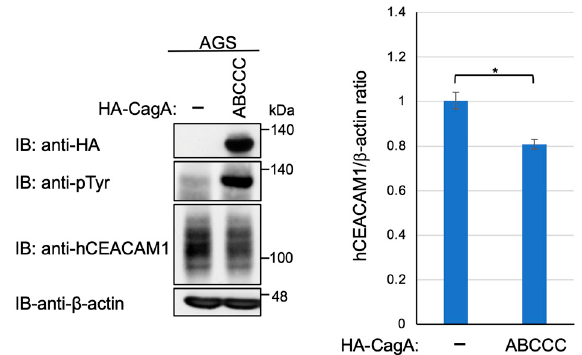
Figure 7. Plasmid-mediated expression of CagA is only a modest reduction in the level of cellular CEACAM protein. AGS cells were transfected with HA-tagged CagA expression vector. The cell lysates were subjected to immunoblotting with indicated antibodies. Experiments were carried out in biological triplicates ( n = 3) and the representative images are shown ( left ). Quantification of the intensity of CEACAM1 relative to β -actin ( right ). Error bars indicate mean ± SD, n = 3. * p < 0.05.